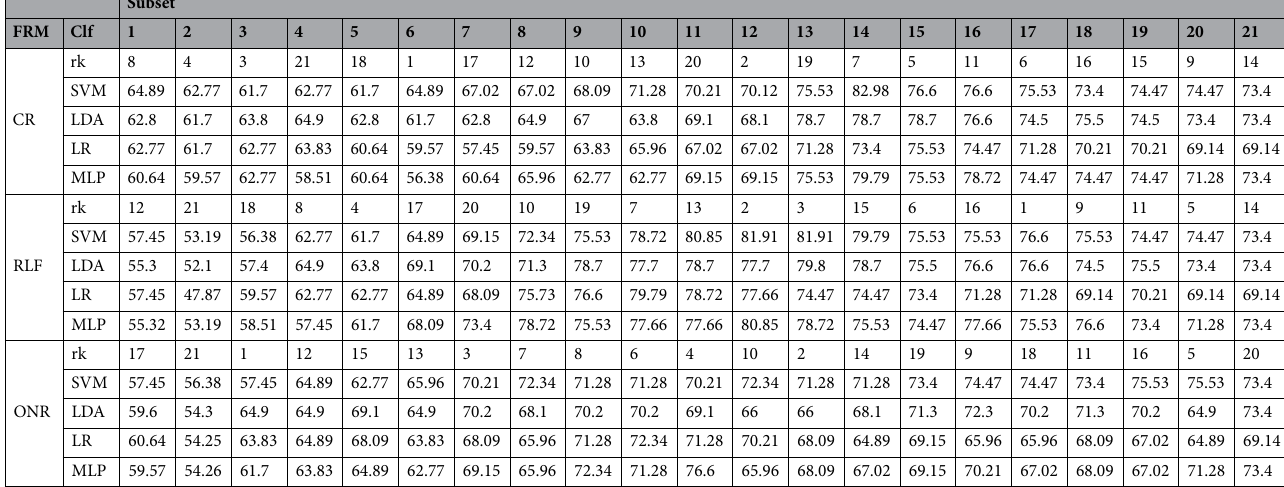
Table 6. A Comparison of results from various Feature-ranking methods against different Machine learning classifiers using C. burnetii